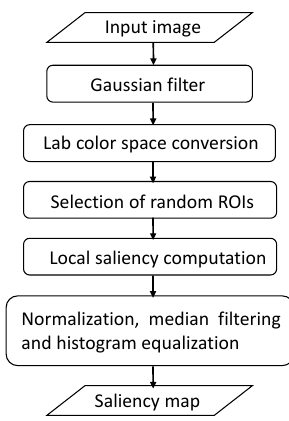
Figure 6. Flowchart of the RCS saliency